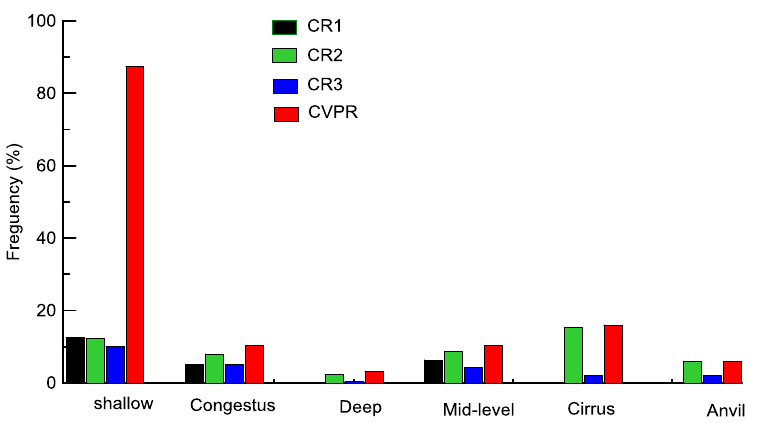
Figure 10. Mean frequency of observed cloud types from CR three modes and CVPR.